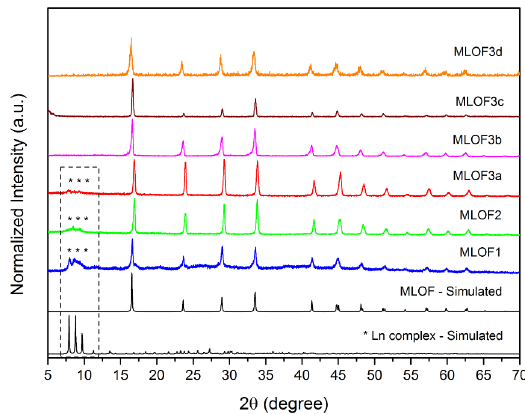
Figure 1. PXRD patterns of the synthesized MLOFs samples in comparison with the simulated from single-crystal data PXRD patterns of MLOF and